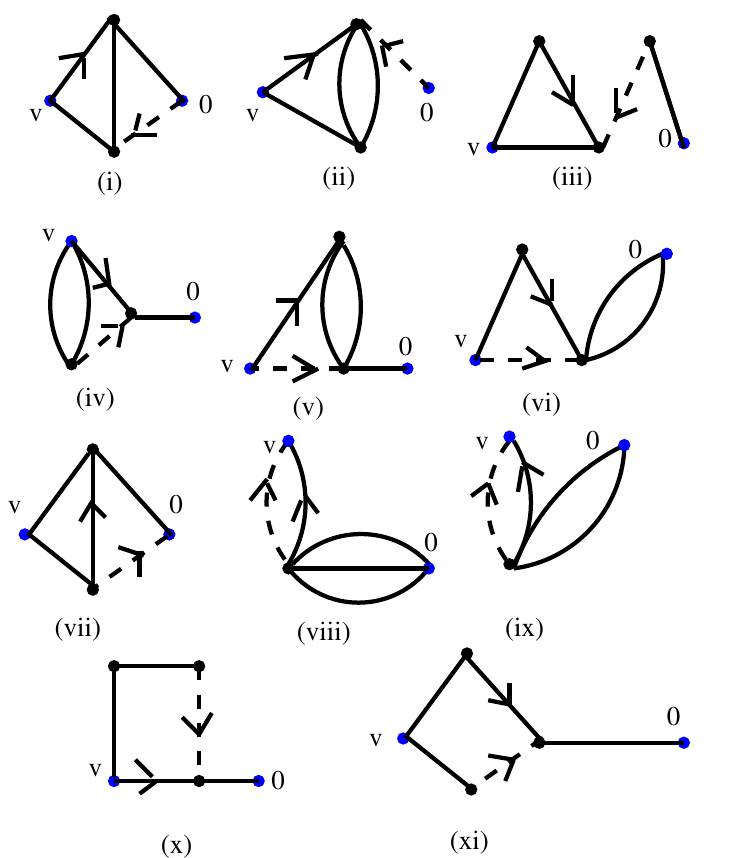
Figure 13 . (i) πF 1 ( v ) , (ii) πF 2 ( v ) , (iii) πF 3 ( v ) , (iv) πF 4 ( v ) , (v) πF 5 ( v ) , (vi) πF 6 ( v ) , (vii) πF 7 ( v )